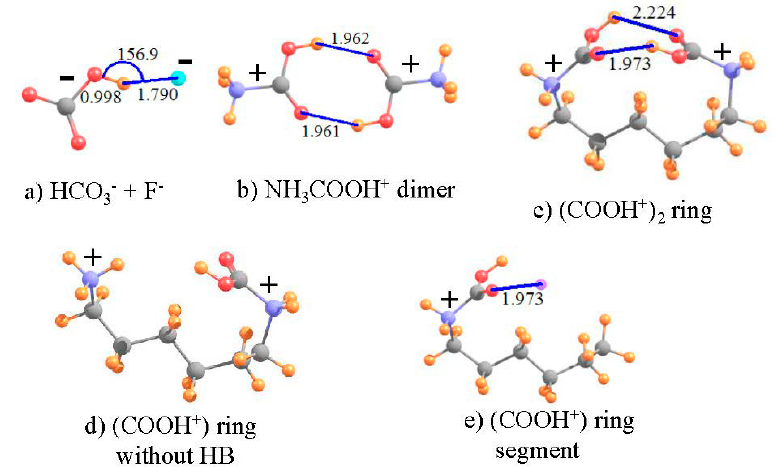
Figure 6. Pairs of like-charged ions; distances in Å, angles in degrees. Purple sphere in ( d ) indicates position of H-bonding proton from right hand COOH group. Table 5. NMR isotropic shielding (ppm) of ion-ion structures shown in Figure 6, along with density at bond critical points ( ρ BCP ) in 10 − 3 au.